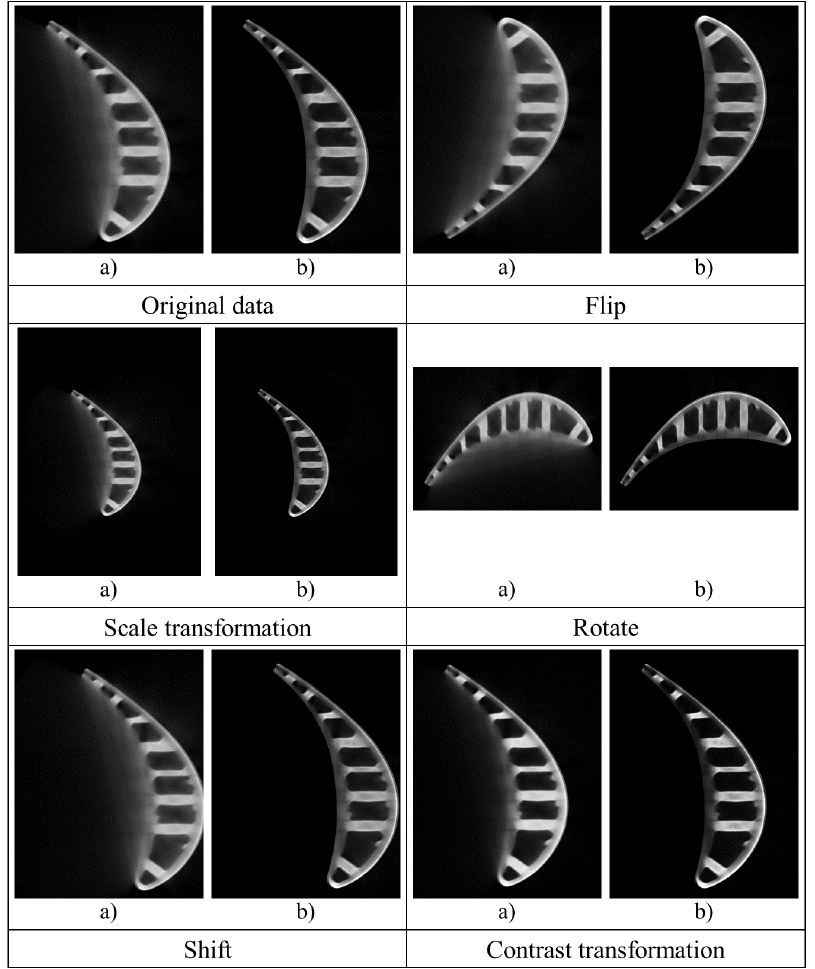
Figure 3. ( a ) The original ICT image; ( b ) the label for ( a